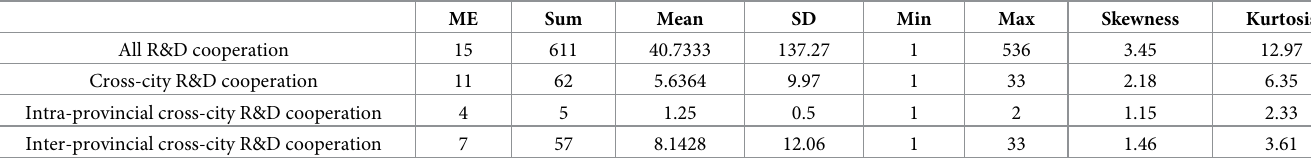
Table 7. Descriptive statistics of Beijing-Tianjin-Hebei region 2014–2016.